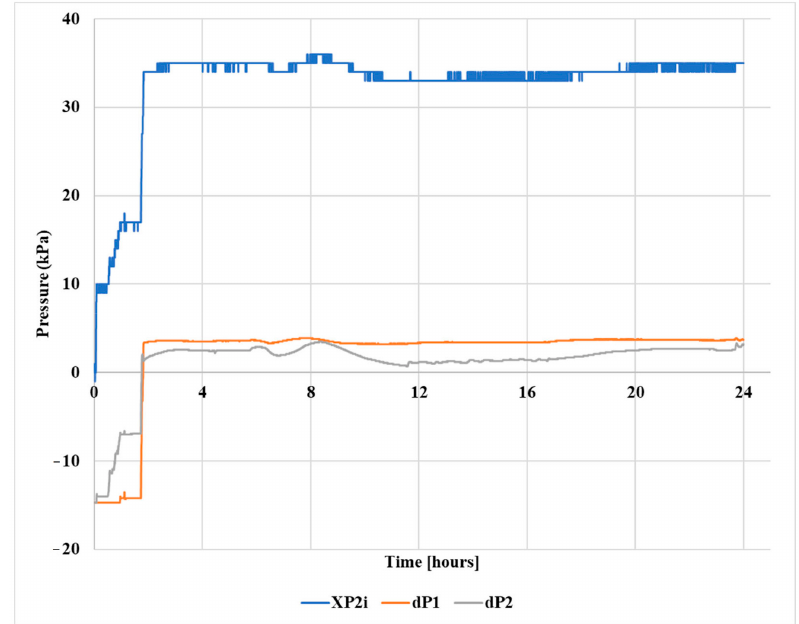
Figure 10. Recorded pressure during an experiment in a vertical fluid column using the laponite gel pill. The bottom hole pressure is shown as the blue line. The differential pressures dP1 and dP2 are shown as the orange and gray lines, respectively.